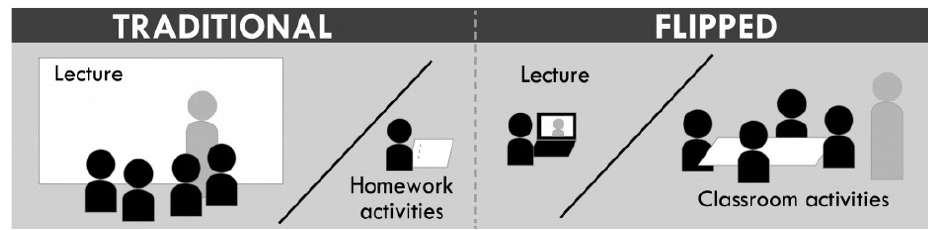
Figure 1. Main difference between traditional and flipped methods. Retrieved from